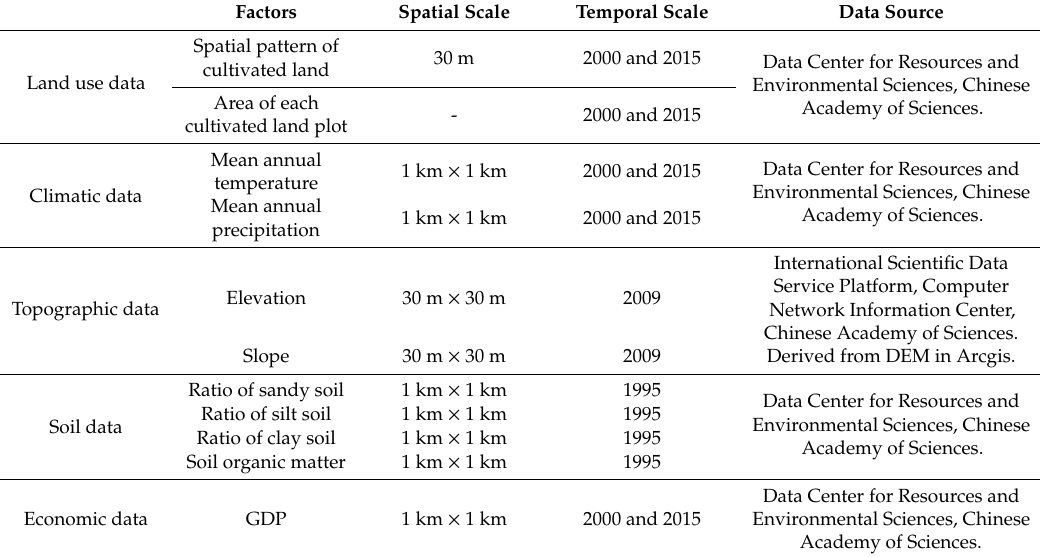
Table 1. Description of the spatial datasets and